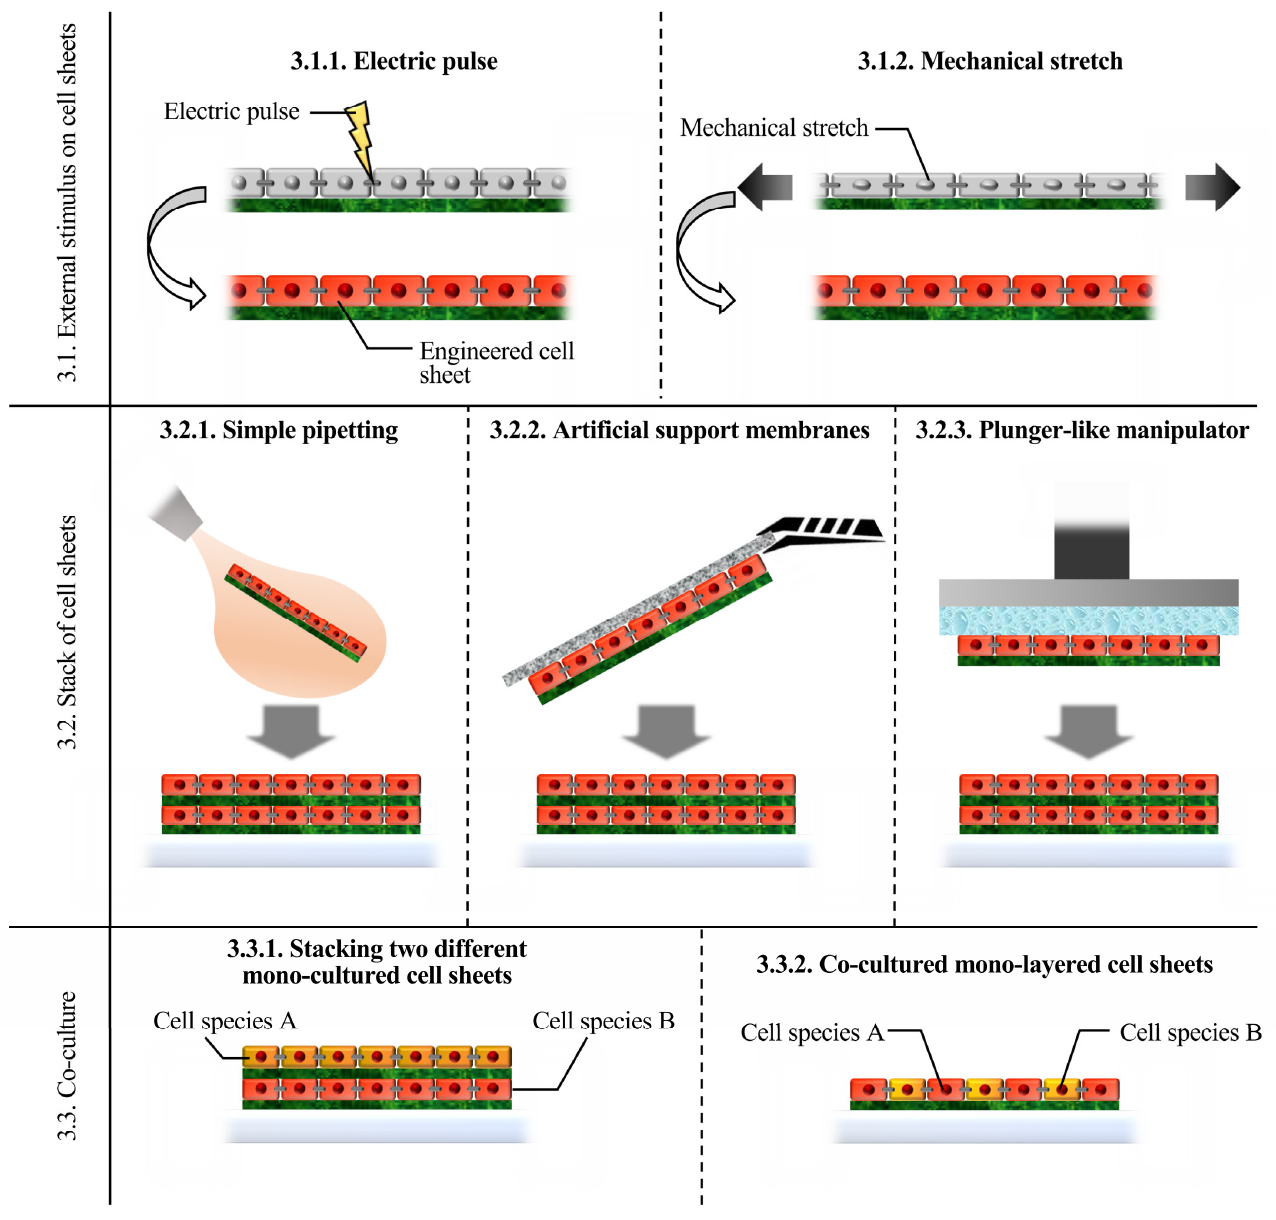
Figure 4. Summary of each cell sheet engineering method introduced in the present review.